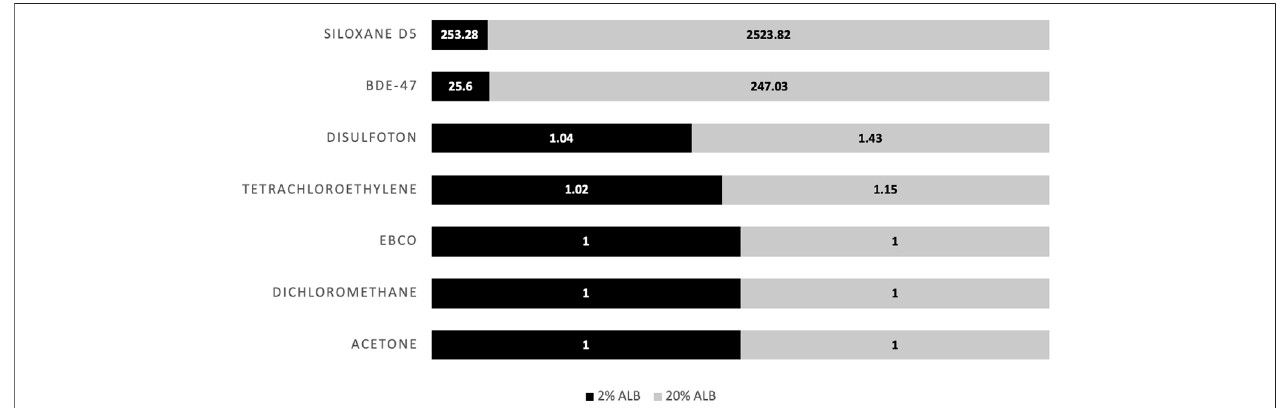
FIGURE6| Facilitatedtransport factors(FTFs) forthedifferentchemicals chosenasillustrative casechemicalsinthepresenceof2%(black)and 20%(grey) serum albumin.